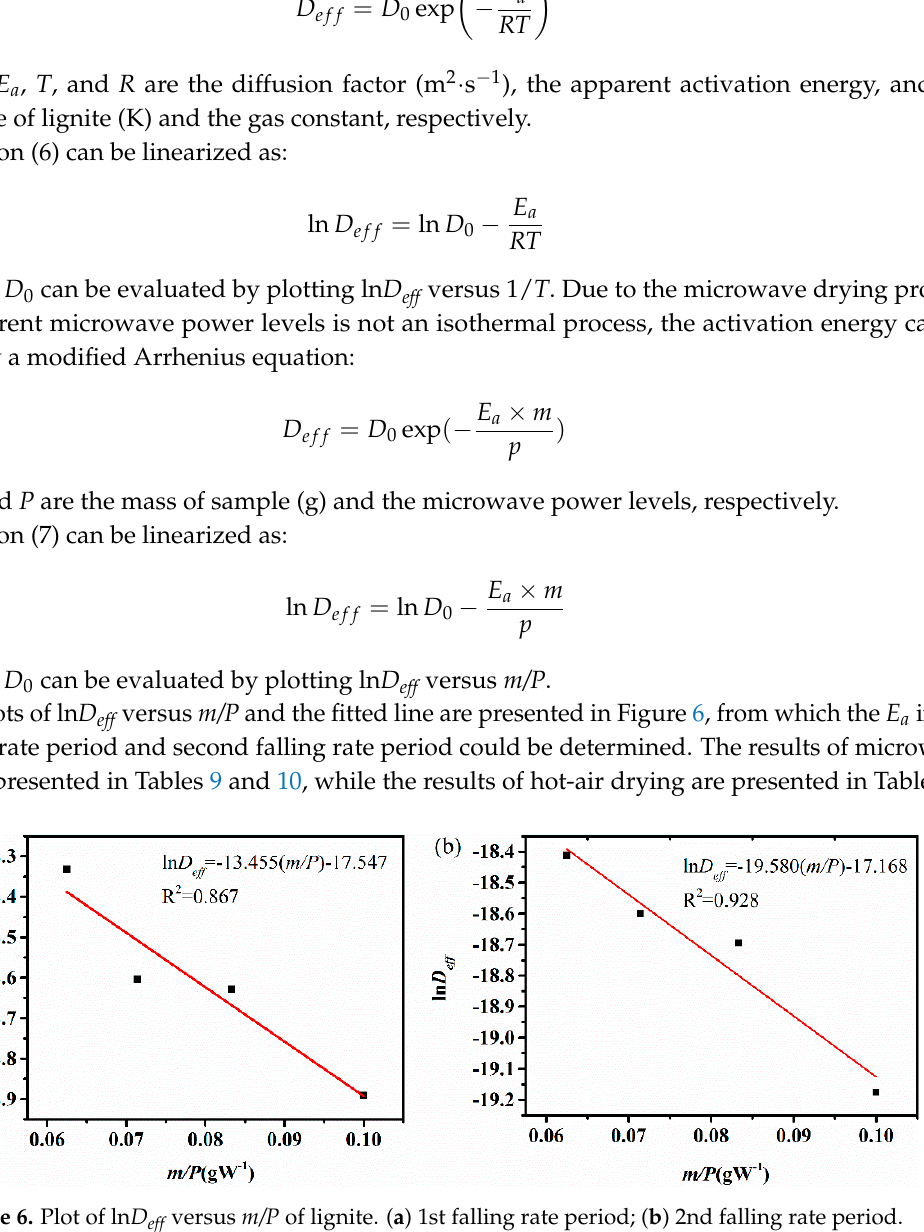
Figure 6. Plot of ln D eff versus m/P of lignite. ( a ) 1st falling rate period; ( b ) 2nd falling rate period. Table 9. Activation energy of lignite at different temperatures during microwave drying.